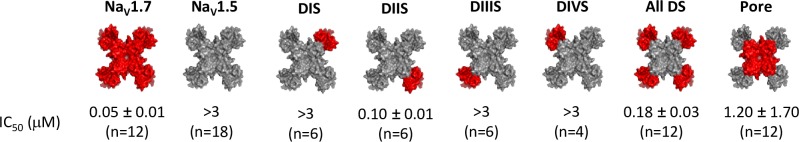
AM-8145 maps to the second voltage sensor domain on hNaV1.7.Potency of AM-8145 inhibition of wild-type NaV1.7, wild-type NaV1.5, or chimeric NaV1.7/NaV1.5 channels (red illustrates NaV1.7 sequence and gray illustrates NaV1.5 sequence) on the IWQ platform (mean ± SEM). D = “Domain”; S = “Sensor” corresponding to transmembrane segments 1–4; P = “Pore” corresponding to transmembrane segments 5–6. AM-8145 block of wild-type NaV1.7 is similar to chimera DIIS containing the second voltage sensor domain of NaV1.7 embedded in the NaV1.5 backbone.